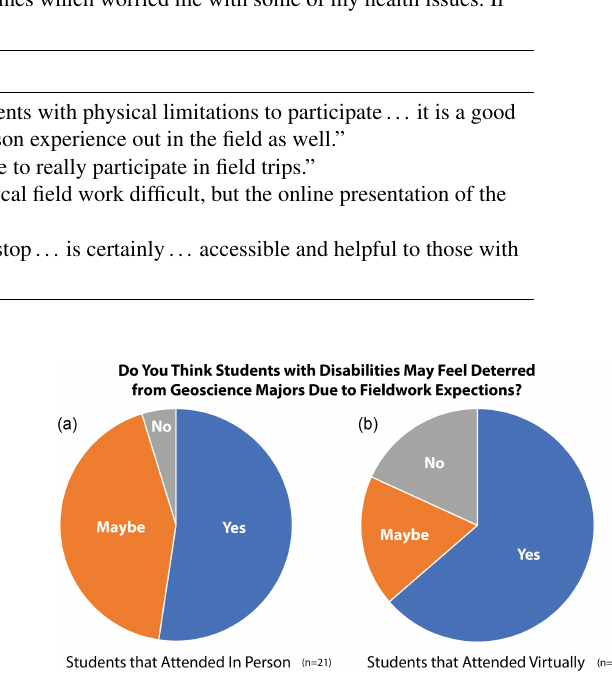
Figure 7. Responses from students of both in-person and virtual modalities on whether they thought students are discouraged from majoring in the geosciences due to a fieldwork requirement in un- dergraduate